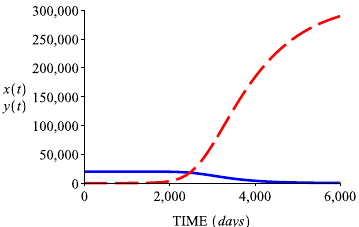
Figure 4. Behavior of the normal and leukemic stem cell populations in Case II (accelerated-acute phase). Initial conditions: x ( 0 ) = 2 × 10 4 , y ( 0 ) = 1.